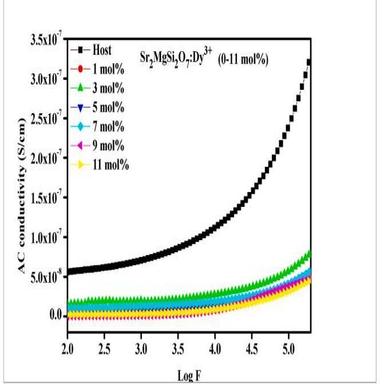
AC conductivity versus Log F for Sr2MgSi2O7:Dy3þ NPs.